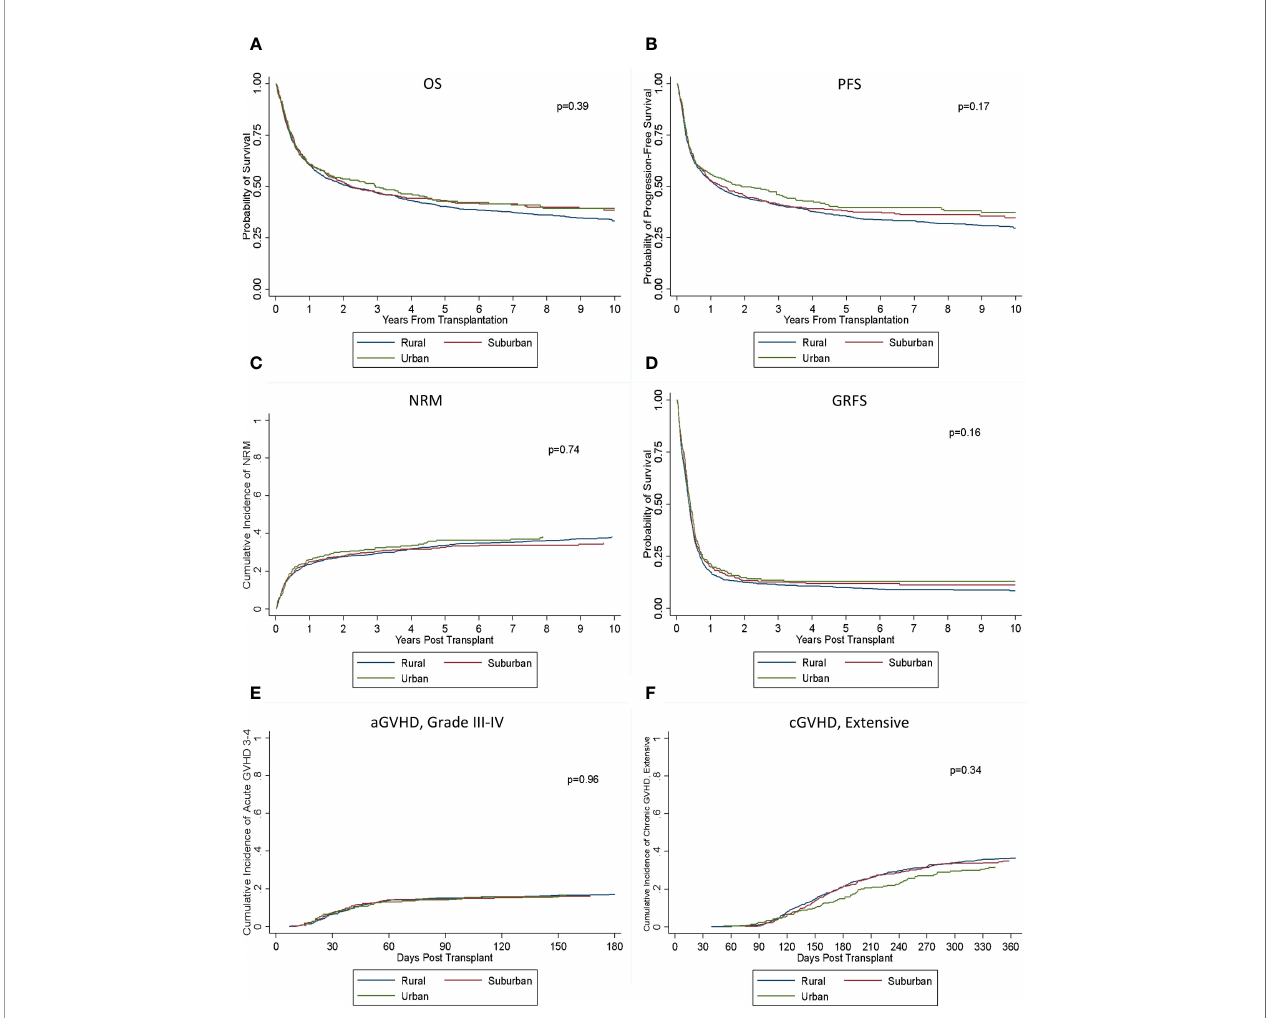
FIGURE 2 | Outcomes based on location of residence. There was no signi fi cant difference in (A) OS, (B) PFS, (C) NRM, (D) GRFS, (E) aGVHD III – IV, or (F) cGVHD (extensive) between the